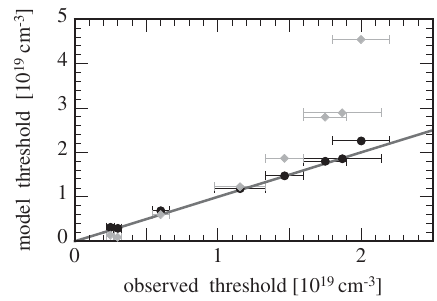
FIG. 5. Plot of reported density threshold, n t , versus predicted density threshold, n model , for this and other published experi- ments [2,11,25,36]. Circles show the predictions of our model, diamonds show the threshold based on (cid:1)P=P c > 3 . The line indicates n t ¼ n model